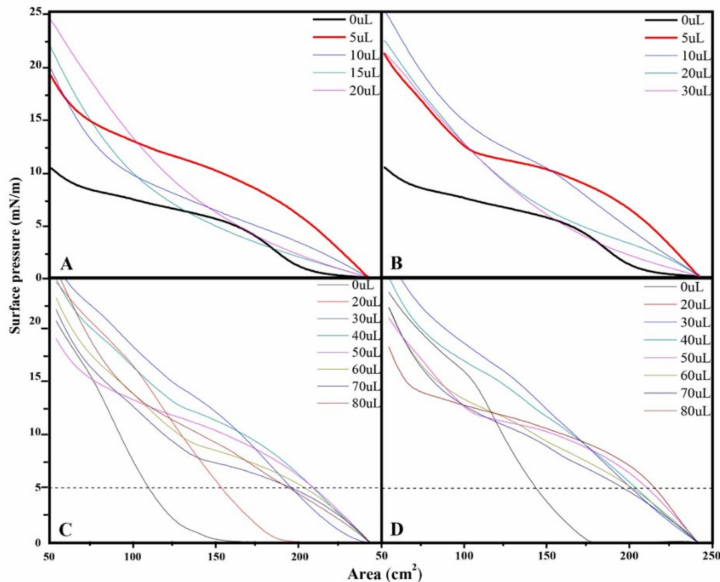
Figure 3. Surface pressure-area isotherms from the monolayer trough: ( A ); AmB (50 µ L) with increasing volume of lipids extracts from environmental isolate; ( B ) AmB (50 µ L) with